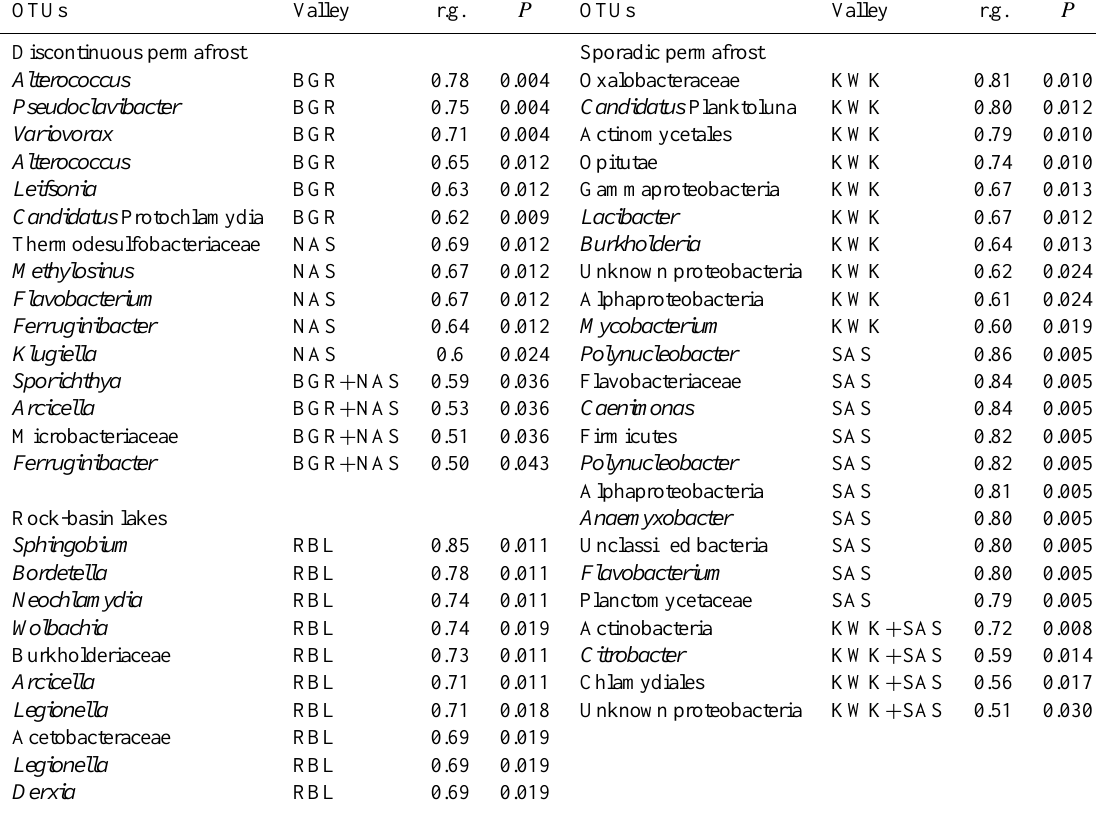
Table 2. Results of indicator species analysis. Valley refers to the valley (or combination of valleys) for which the OTUs obtained the highest correlation. We indicate the correlation value (r.g.) and its statistical significance ( P ) at α = 0.05. Only OTUs with r.g. ≥ 0.6 are presented when associated with one valley (top 10 are presented for the KWK and SAS valleys). OTUs were classified at their finest taxonomic levels based on similarity to sequences in GenBank.